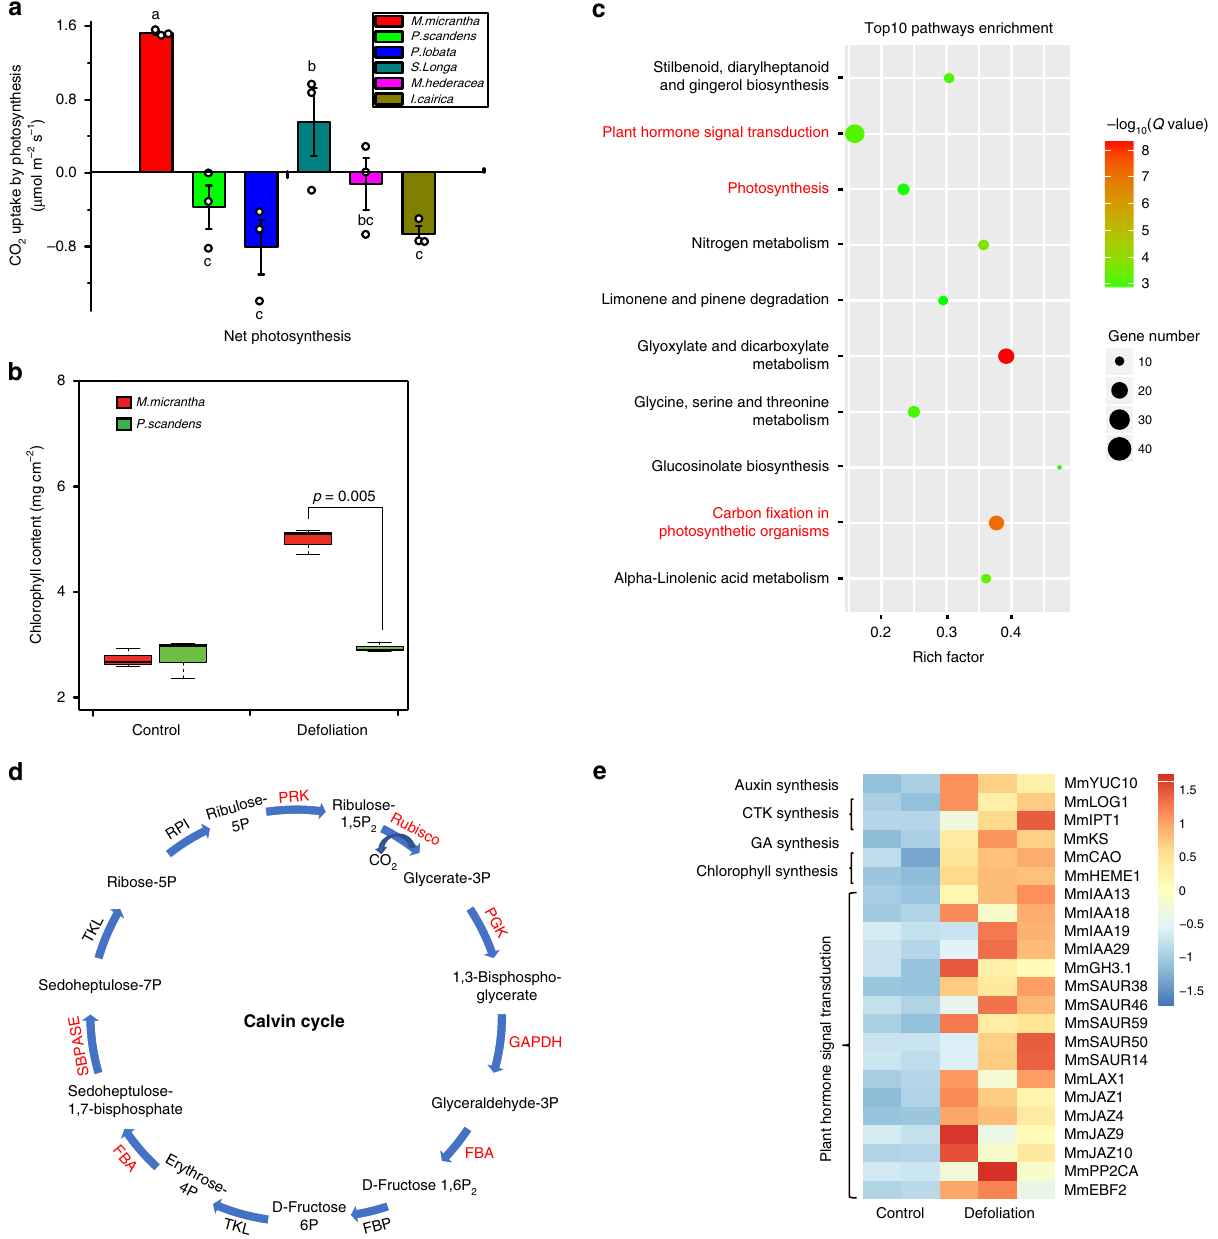
Fig. 4 Identi fi cation of stem photosynthesis in Mikania micrantha . a Comparison of the net photosynthetic rate of M. micrantha to that of fi ve neighboring species, namely, Paederia scandens , Pueraria lobata , Stephania longa , Merremia hederacea , and Ipomoea cairica . Statistical signi fi cance ( n = 3) determined using one-way ANOVA with Duncan ’ s multiple comparison test. b The change in chlorophyll content in the stem under defoliation conditions compared to that in the control. Statistical signi fi cance ( n = 3) determined using the two-sided Student ’ s t test. On each box plot, the central mark indicates the median, the bottom and top edges of the box indicate the interquartile range (IQR) and the whiskers represent the maximum and minimum data points. c KEGG pathway enrichment of upregulated genes. The signi fi cant enrichment of KEGG pathways related to photosynthesis, carbon fi xation and hormone signal transduction are marked in red. d Comparison of key genes related to the Calvin cycle in the M. micrantha stem between defoliation conditions and the control. The signi fi cantly upregulated genes are marked in red. e Expression pattern of differentially expressed genes involved in auxin, cytokinin, gibberellin, and chlorophyll biosynthesis and plant hormone signal transduction. The gene names of M. micrantha are shown on the right. Error bars indicate average value ± s.e.m. of indicated replicates. The source data underlying Fig. 4a, b, e are provided as a Source Data fi